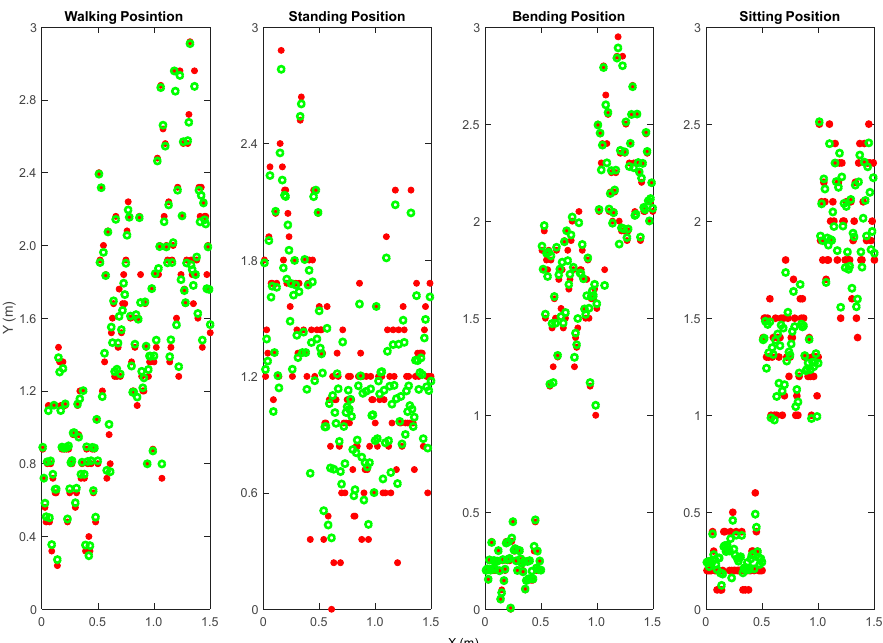
Figure 17. Comparison of reconstructed RFID data and supervised training data .